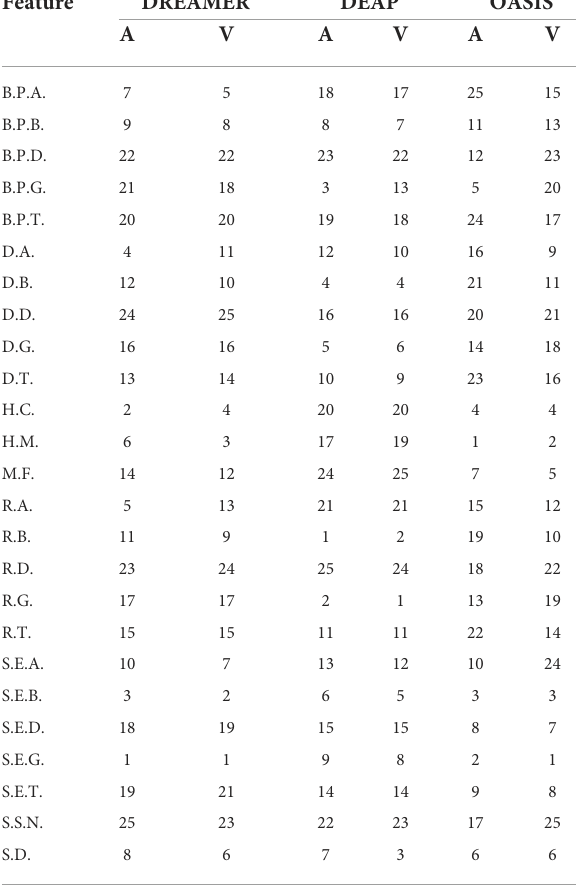
TABLE 3 Feature ranking for valence label (V) and arousal label (A) based on SelectKBest feature selection method. Feature DREAMER DEAP OASIS A V A